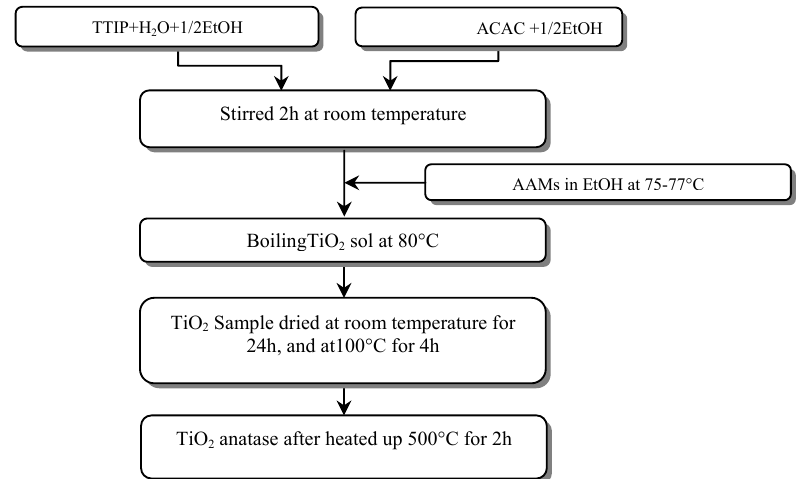
Fig.1: Flow chart showing preparation of TiO